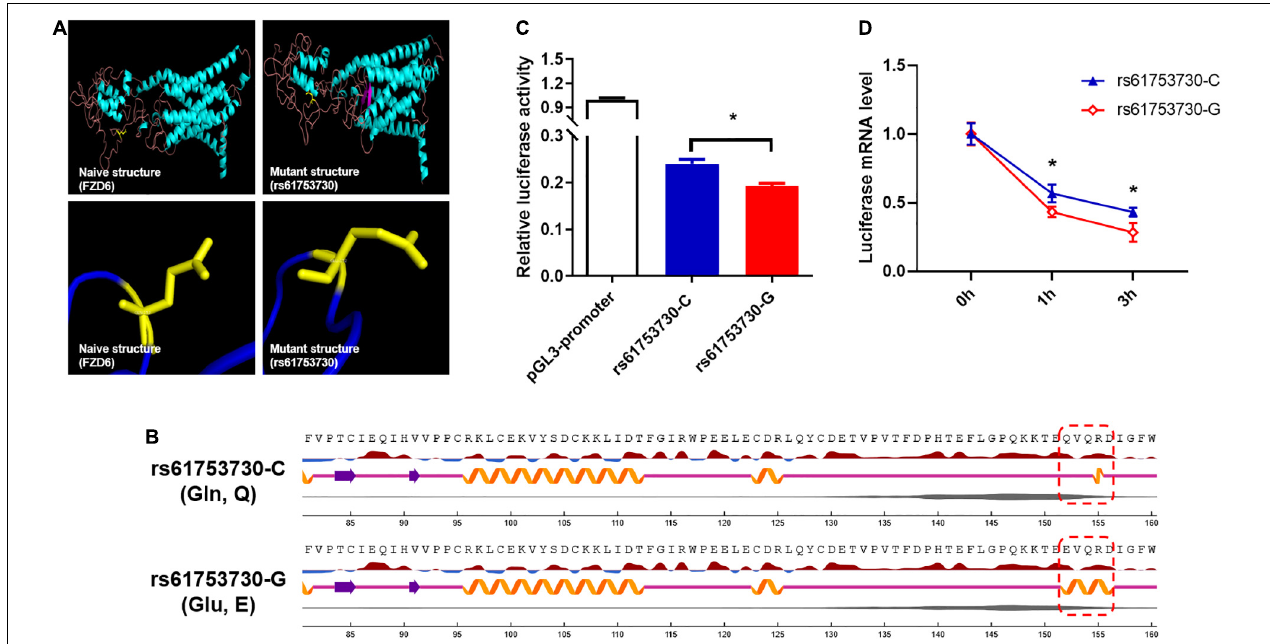
FIGURE 2 | Allele-specific effects of rs61753730 on FZD6 . (A) Effect of rs61753730 mutation on predicted structure of FZD6 protein generated by PyMOL. Upper panel: Naive 3D structure of FZD6 and mutant structure of rs61753730 (Q152E). Bottom panel: Naive structure of FZD6 shows glutamine at position 152, and predicted mutant structure of rs61753730 shows glutamic acid at corresponding position. (B) Effect of rs61753730 mutation on secondary structure of FZD6 at position 152 predicted by NetSurfP-2.0. Box with dashed line in red indicates different structure of WT (C) and mutant SNP (G). (C) Effect of rs61753730 on luciferase activity. HEK293T cells were transfected with rs61753730 C- and G-allele constructs of pGL3-promoter vector. Luciferase activity was measured 48 h later. Data are reported as relative firefly luciferase activity normalized to Renilla luciferase activity and represented as mean ± SEM ( n = 3). * p < 0.05. (D) Effect of rs61753730 on mRNA stability of luciferase reporter gene. HEK293T cells were transfected with rs61753730 C- and G-allele constructs of pGL3-promoter vector for 24 h prior to adding actinomycin D (5 µ g/ml). The mRNA of luciferase expression was measured at different times (0, 1, and 3 h) and normalized to GAPDH . Data are presented as mean ± SEM ( n = 3). * p <